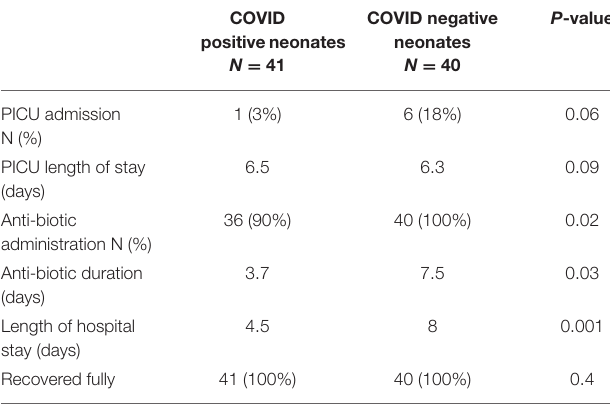
TABLE 5 | Hospital stay and antibiotic